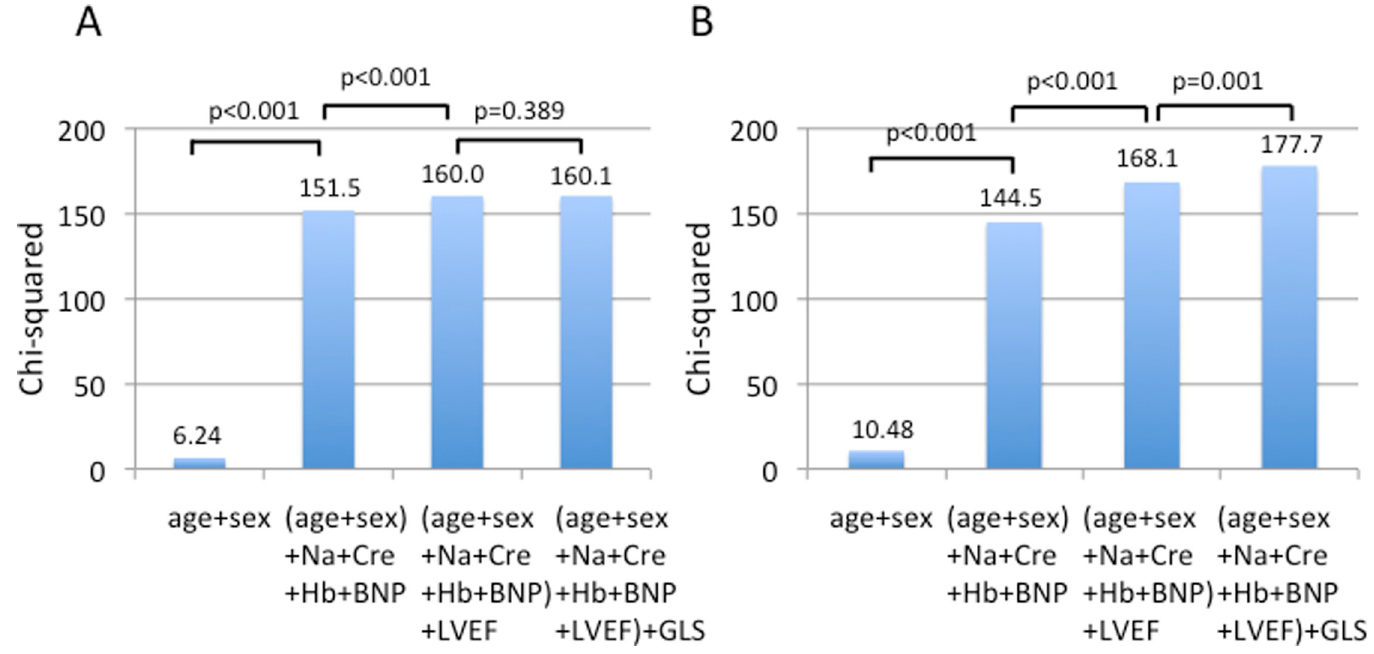
Fig 5. Nested regression model assessing incremental values of blood examination parameters and GLS in the validation group. BNP, sodium, creatinine and hemoglobin afforded significant incremental improvement over the model including age and sex, and LVEF provided significant additional prognostic value over the model including age, sex, BNP, sodium, creatinine and hemoglobin. The further addition of GLS had no incremental value for predicting risk of cardiac death (A) but had a significant incremental value for predicting major adverse cardiovascular events (MACEs; B). BNP; B-type natriuretic peptide, Cre; creatinine, GLS; global longitudinal strain, Hb; hemoglobin, LVEF; left ventricular ejection fraction, Na; sodium.